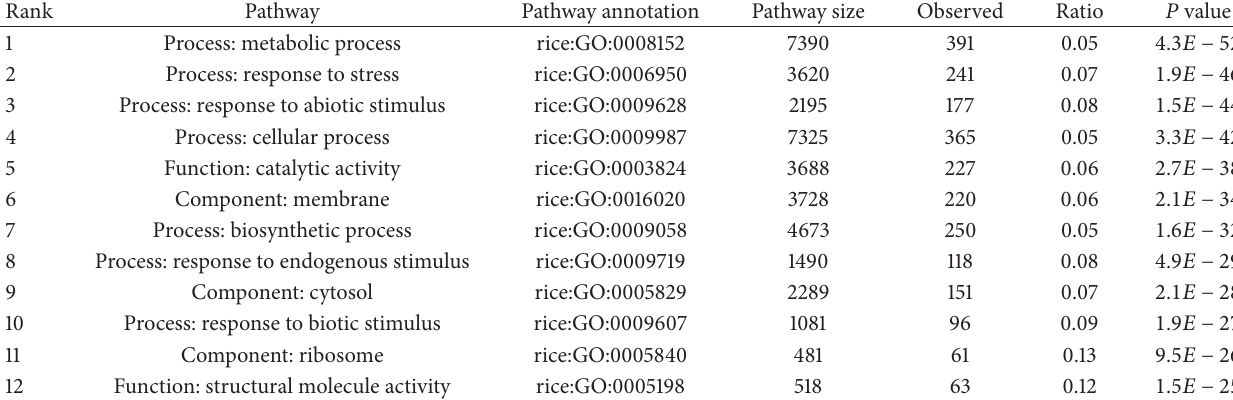
Table 1: Top ranked pathways that are regulated (1374 genes) at 25 ∘ C by GO analysis. Rank Pathway Pathway annotation Pathway size